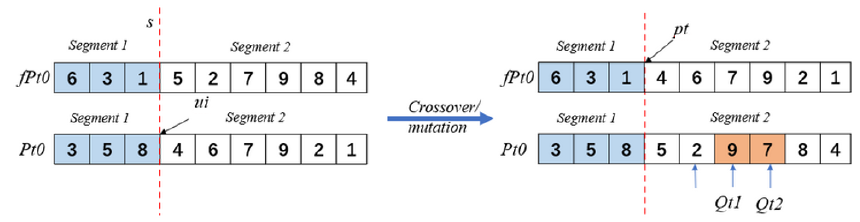
Figure 10. Population selection